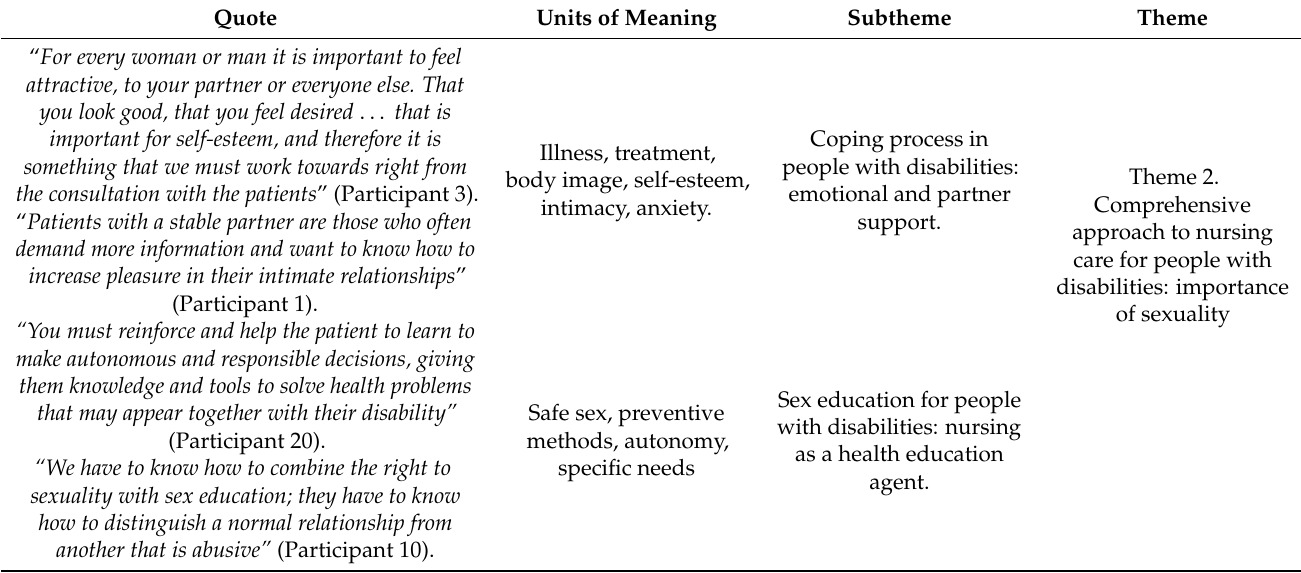
Table 3. Example of the codification